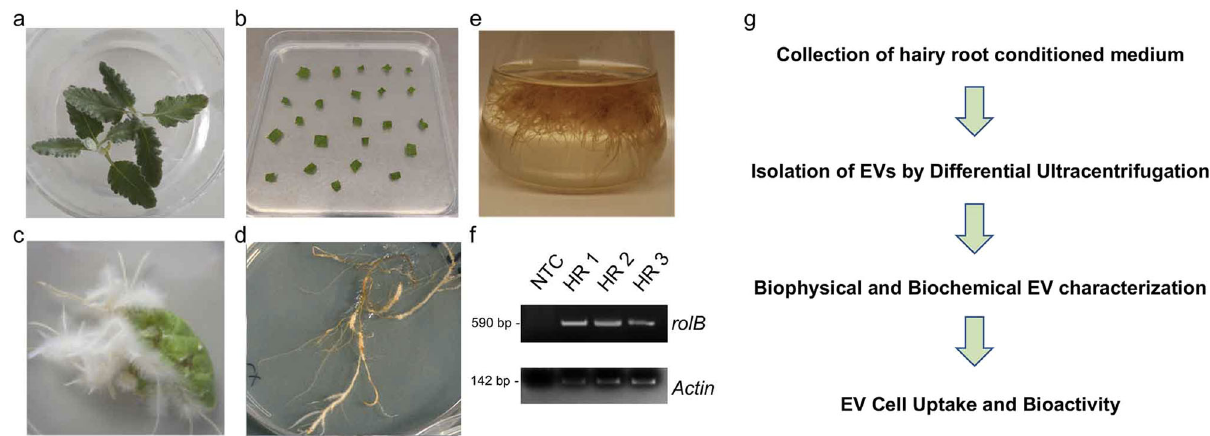
Fig. 1 Experimental design for the production and characterization of S. dominica hairy root derived EVs. a Plantlets of Salvia dominica grown in vitro. b Sterile leaf sections infected by A. rhizogenes . c Hairy roots (HRs) development from infected leaves. d Subcultures of excised hairy roots in solid hormone free medium. e HR in the hormone-free liquid MS medium. f Stable integration of the rolB gene in HRs assessed by polymerase chain reaction (PCR) in three independent transformation events. Amplicon length: 451 base pairs (bp) and 142 bp for rolB and actin genes, respectively. NTC, no template control. g Work fl ow planned for the puri fi cation and characterization steps of extracellular vesicles released by S. dominica HRs.